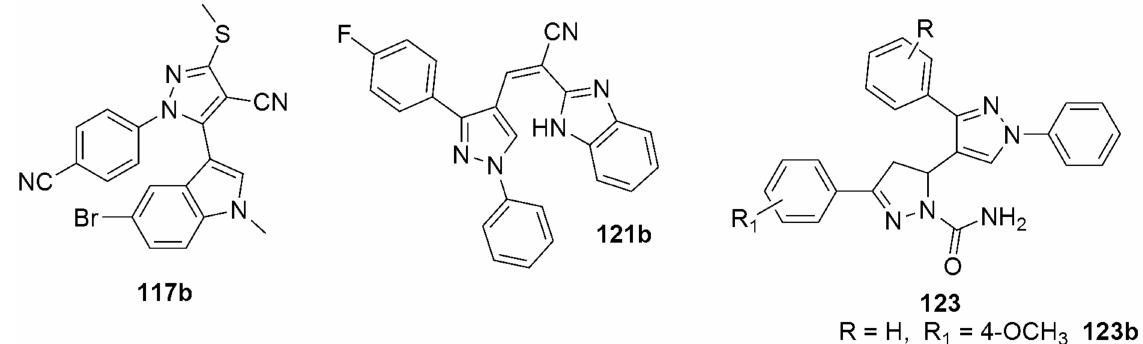
Figure 6. Pyrazole hybrids with anticancer